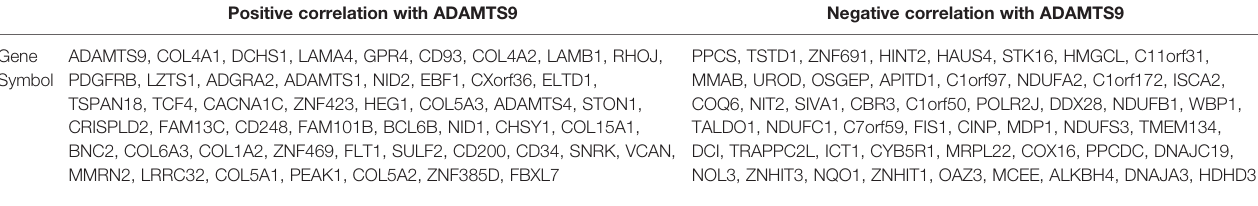
TABLE 1 | Top 50 genes positively and negatively related to ADAMTS9.